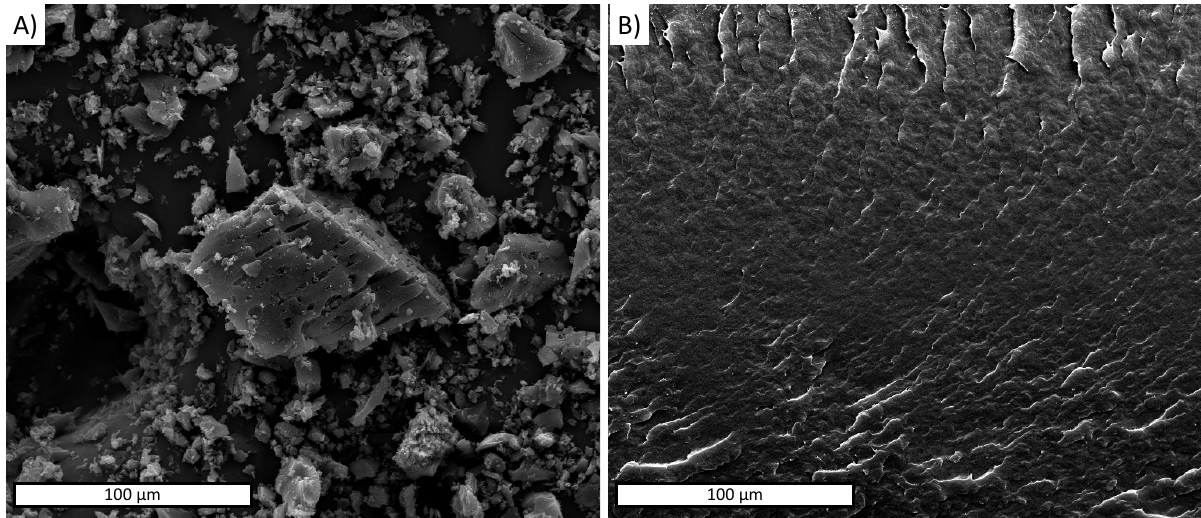
Figure 3. SEM micrographs of ( A ) biochar particles and ( B ) PBAT nitrogen-fractured surface.